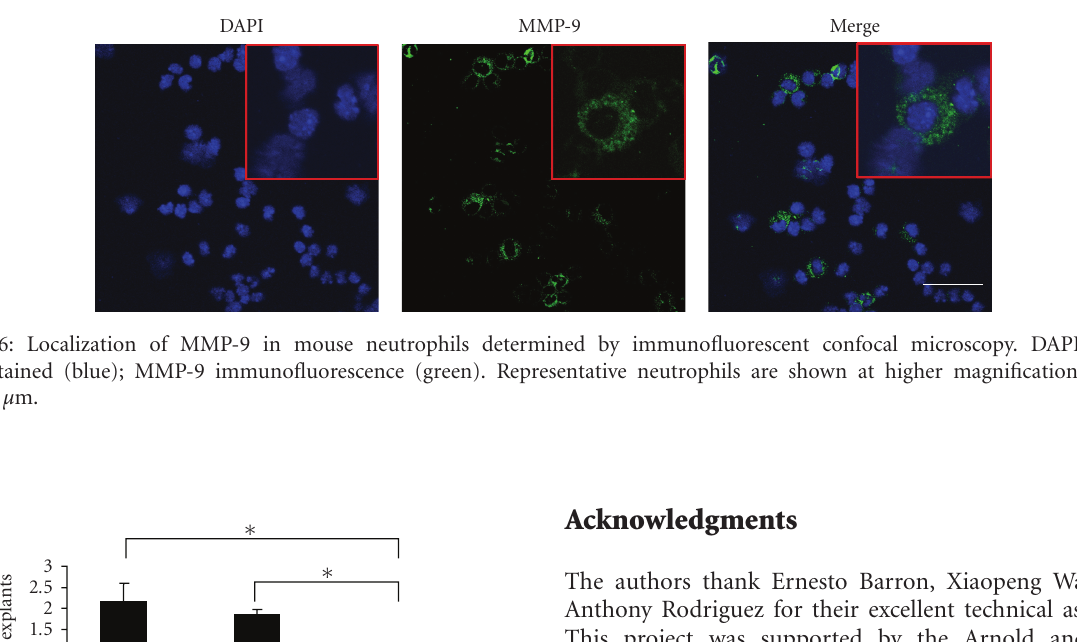
DAPI MMP-9 Merge